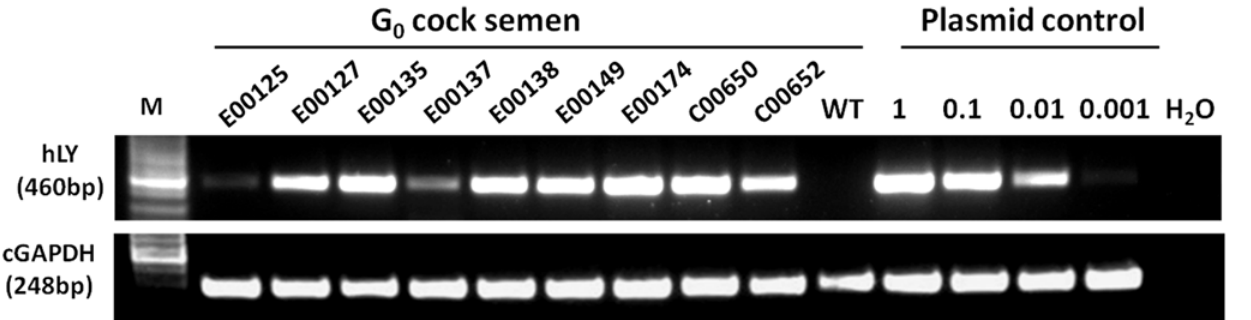
Fig 3. PCR analyses of semen DNA from G 0 males with an integrated hLY fragment. To estimate approximate copy numbers, control PCR reactions were performed in parallel, using 500 ng aliquots of chicken genomic DNA containing appropriate quantities of plasmid DNA to simulate a single-copy gene (1); a 10-fold dilution of a single-copy gene (0.1); a 100-fold dilution of a single-copy gene (0.01); and a 1000-fold dilution of a single-copy gene (0.001). 20 ng of genomic DNA were used for the amplification of the chicken housekeeping gene GAPDH. WT, wild-type White Leghorns.